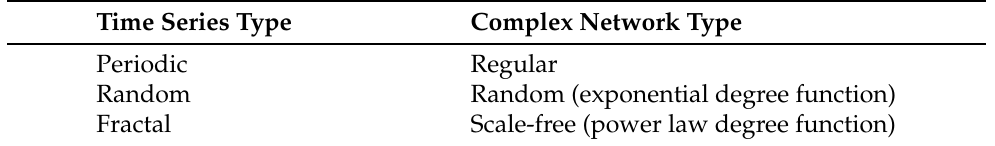
Table 4. Correspondence between time series and complex networks.